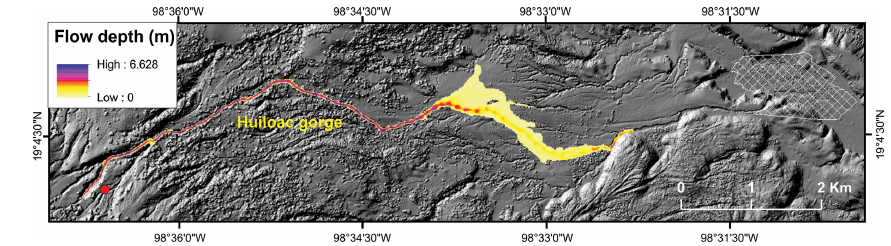
Figure 10. Final map constructed based on maximum flow depths (m) from the different lahar scenarios simulated here.